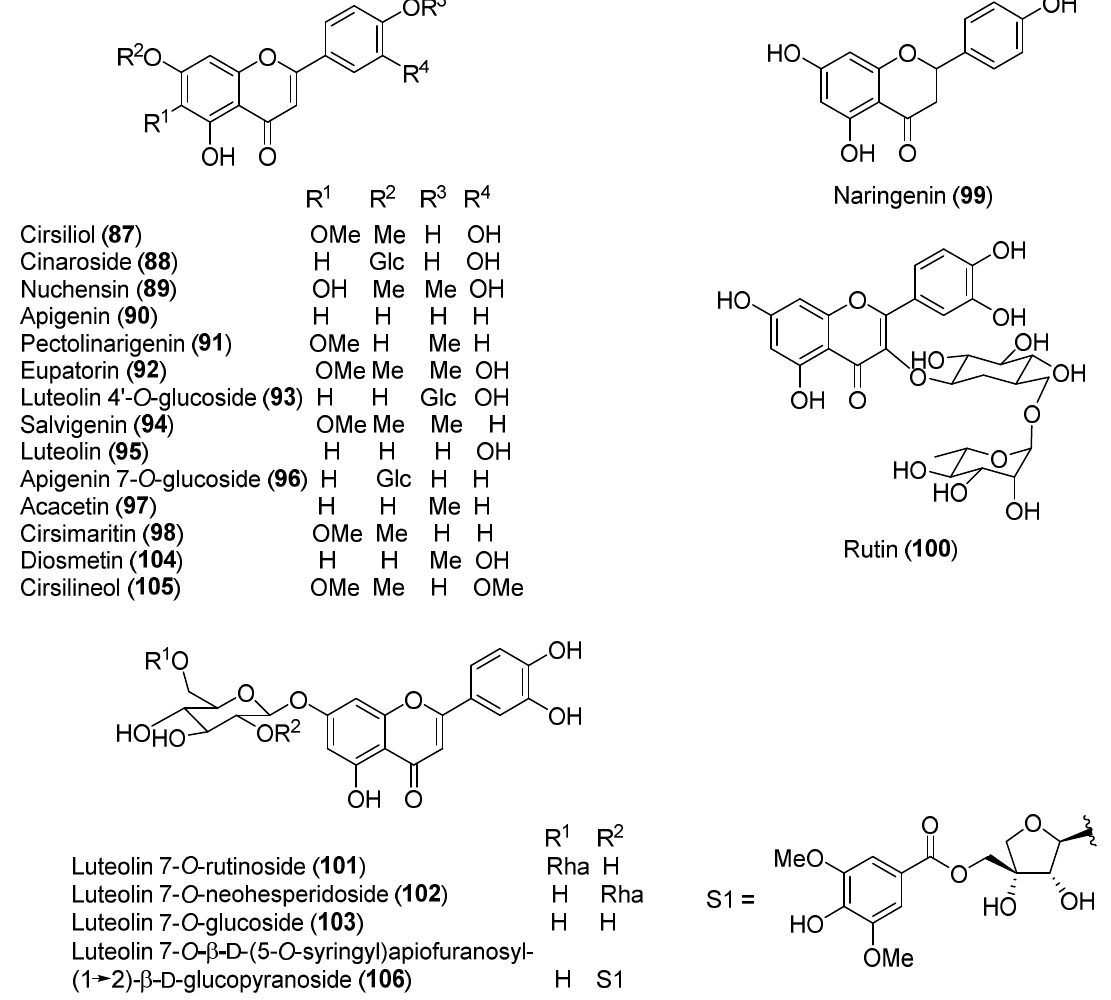
Figure 6. Representative flavonoids isolated from Teucrium chamaedrys , Teucrium oliverianum and Teucrium polium .